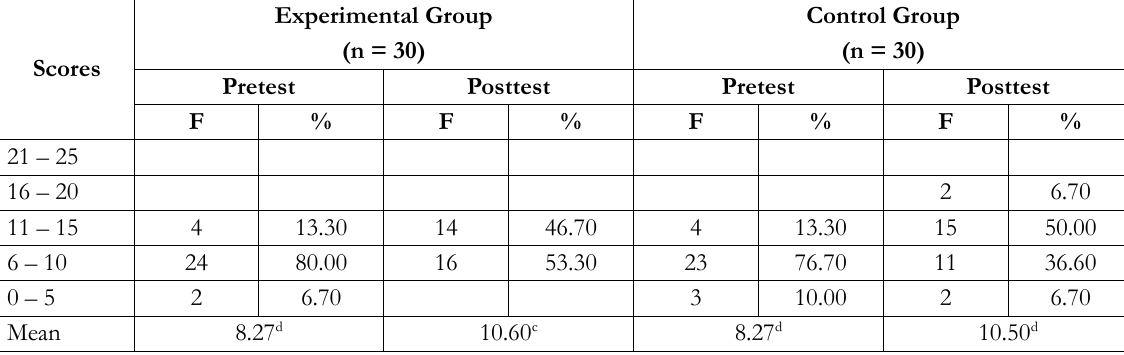
Table 1. Pretest and Posttest Performances of the Participants on Conceptual